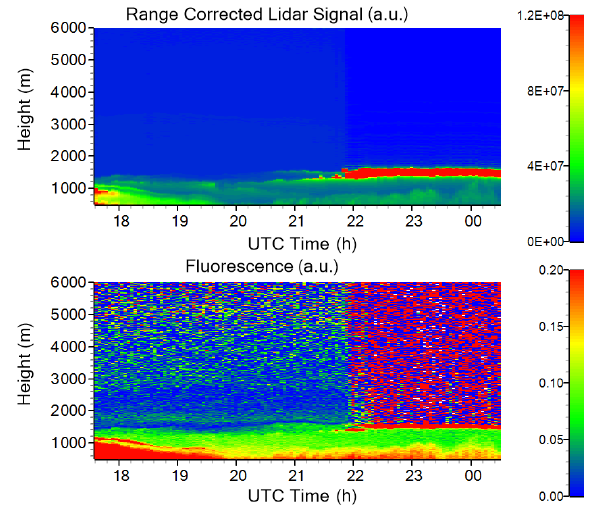
Figure 5. Height–time distribution of the range-corrected lidar sig- nal at 1064nm and fluorescence backscattering coefficient β F (in arbitrary units) on 19–20 November 2019.